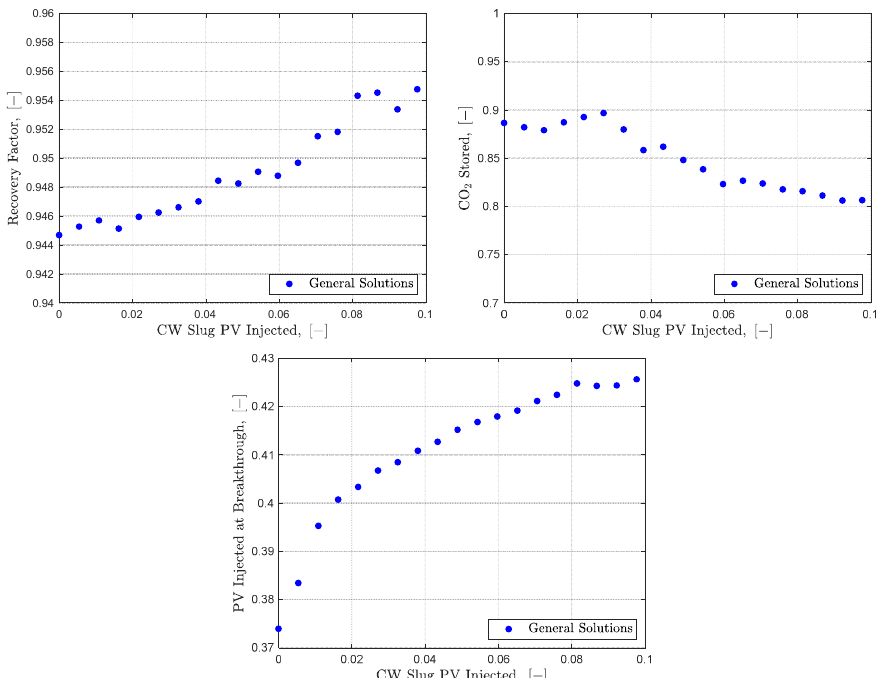
Figure 11. Recovery factor (top left), CO 2 stored (top right), and PV injected at CO 2 breakthrough (bottom) as a function of carbonated water slug volume injected.